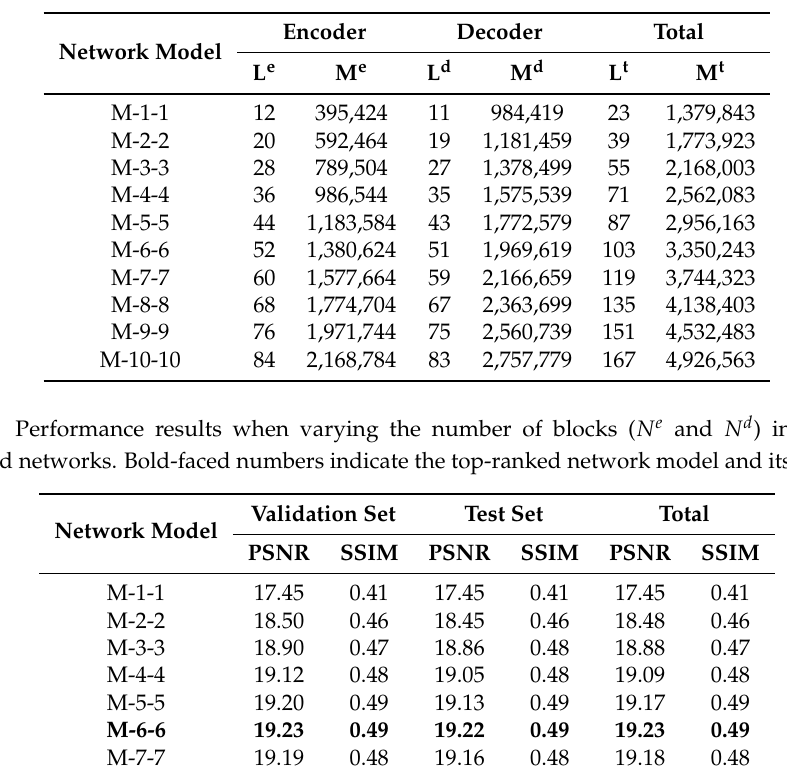
Table 2. Number of layers and parameters when varying the number of blocks ( N e and N d ) in symmetric structured networks.